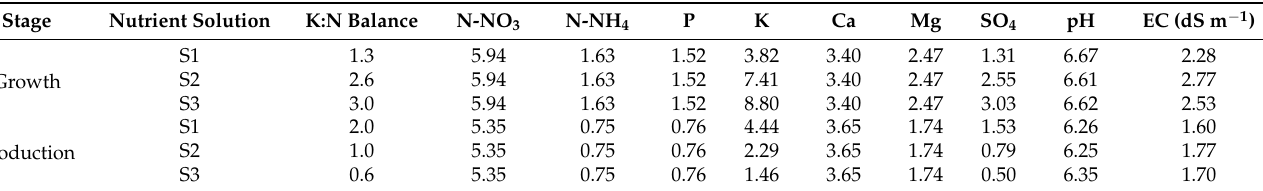
Table 1. Nutrient solutions composition (mmol L − 1